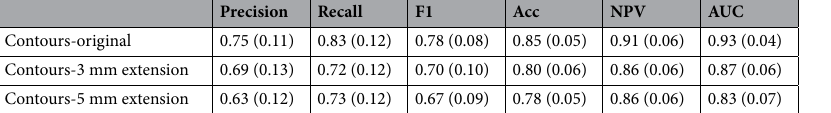
Precision Recall F1 Acc NPV AUC